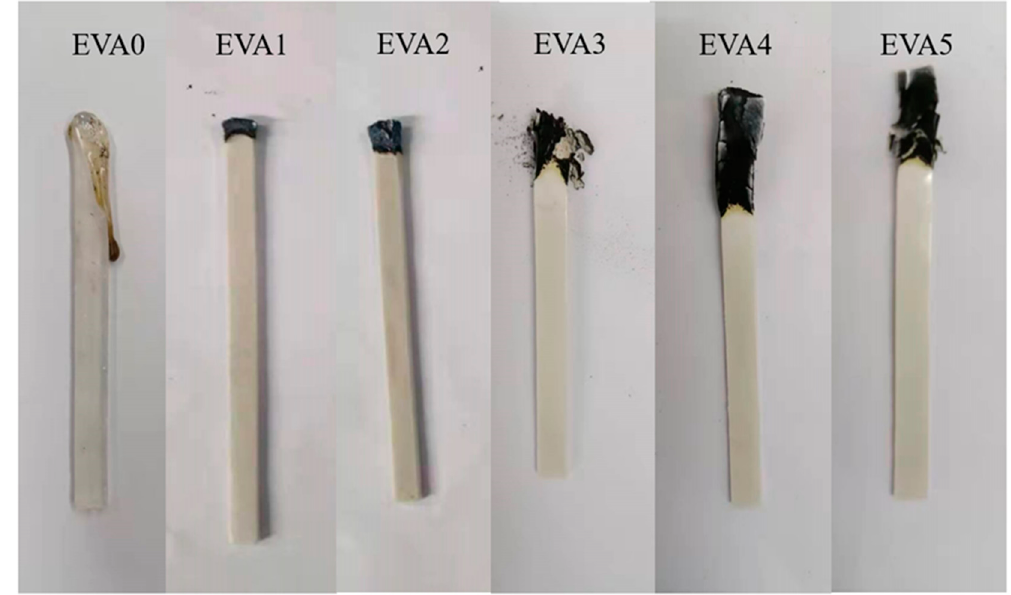
Figure 7. Digital photos of neat EVA and EVA/MH composites after LOI test.